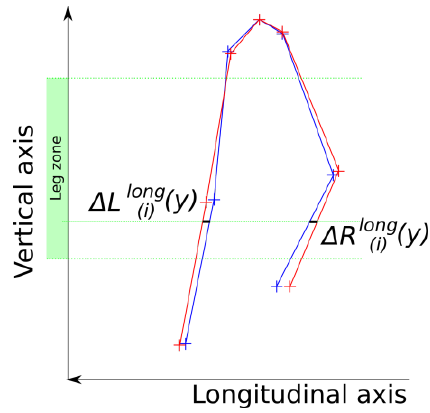
Figure 4. Localization of the longitudinal difference between corresponding legs when using skeleton